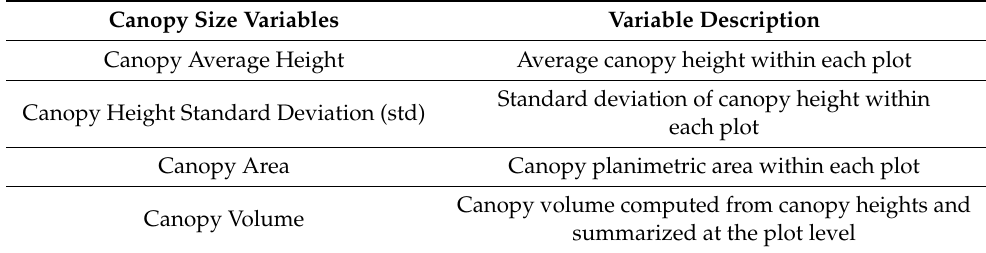
Table 2. Canopy Size